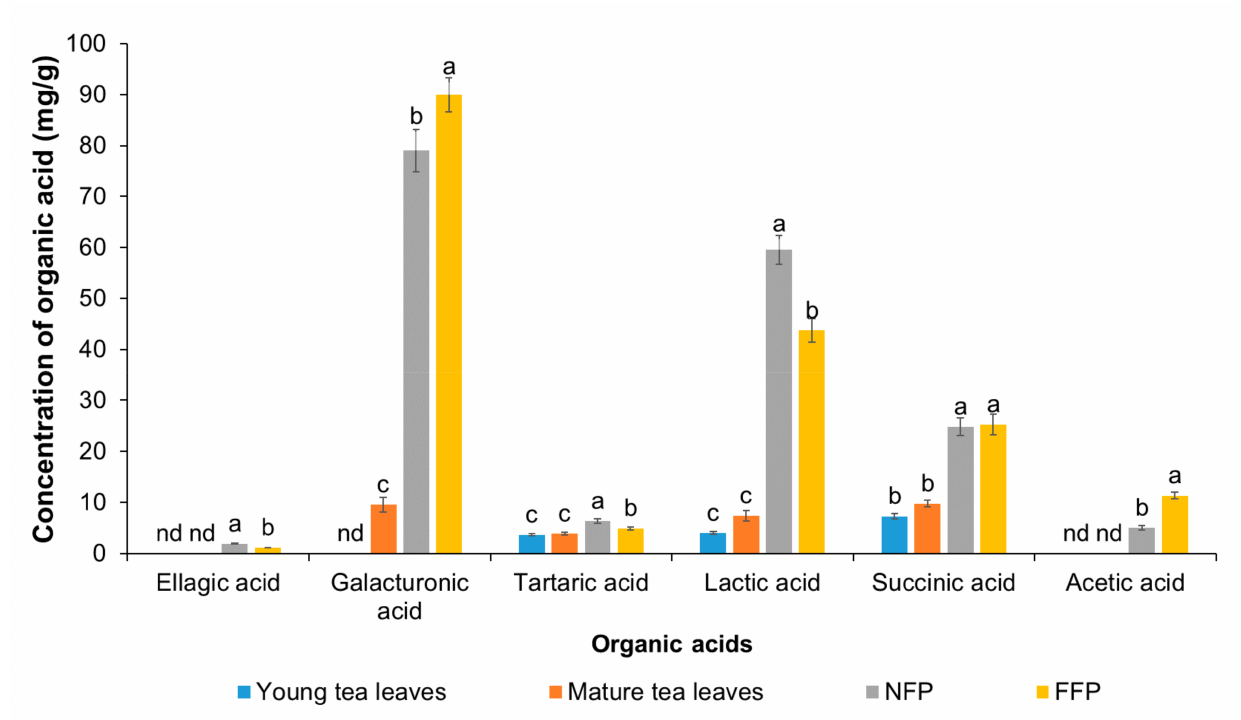
Figure 3. The contents of organic acids in Miang samples: Young tea leaves, mature tea leaves, non-filamentous fungi- process-based fermented leaves (NFP-Miang), and filamentous fungi-process-based fermented leaves (FFP-Miang). Different letters represent significant differences in group concentrations at p < 0.05, and “nd” represents “not